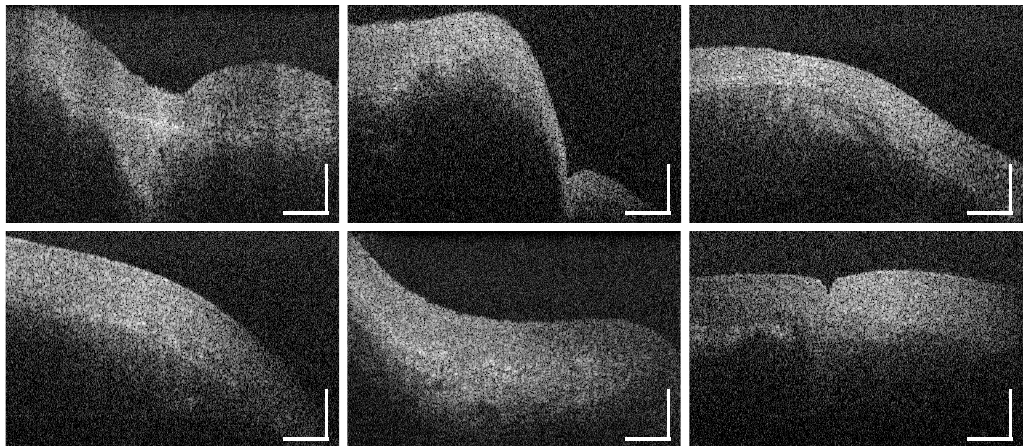
Figure A26. Supplementary intensity-based OCT cross sections of the mucosal tissue of the palatine tonsil (MP16, Figure 1). Scale bars: 200 µ